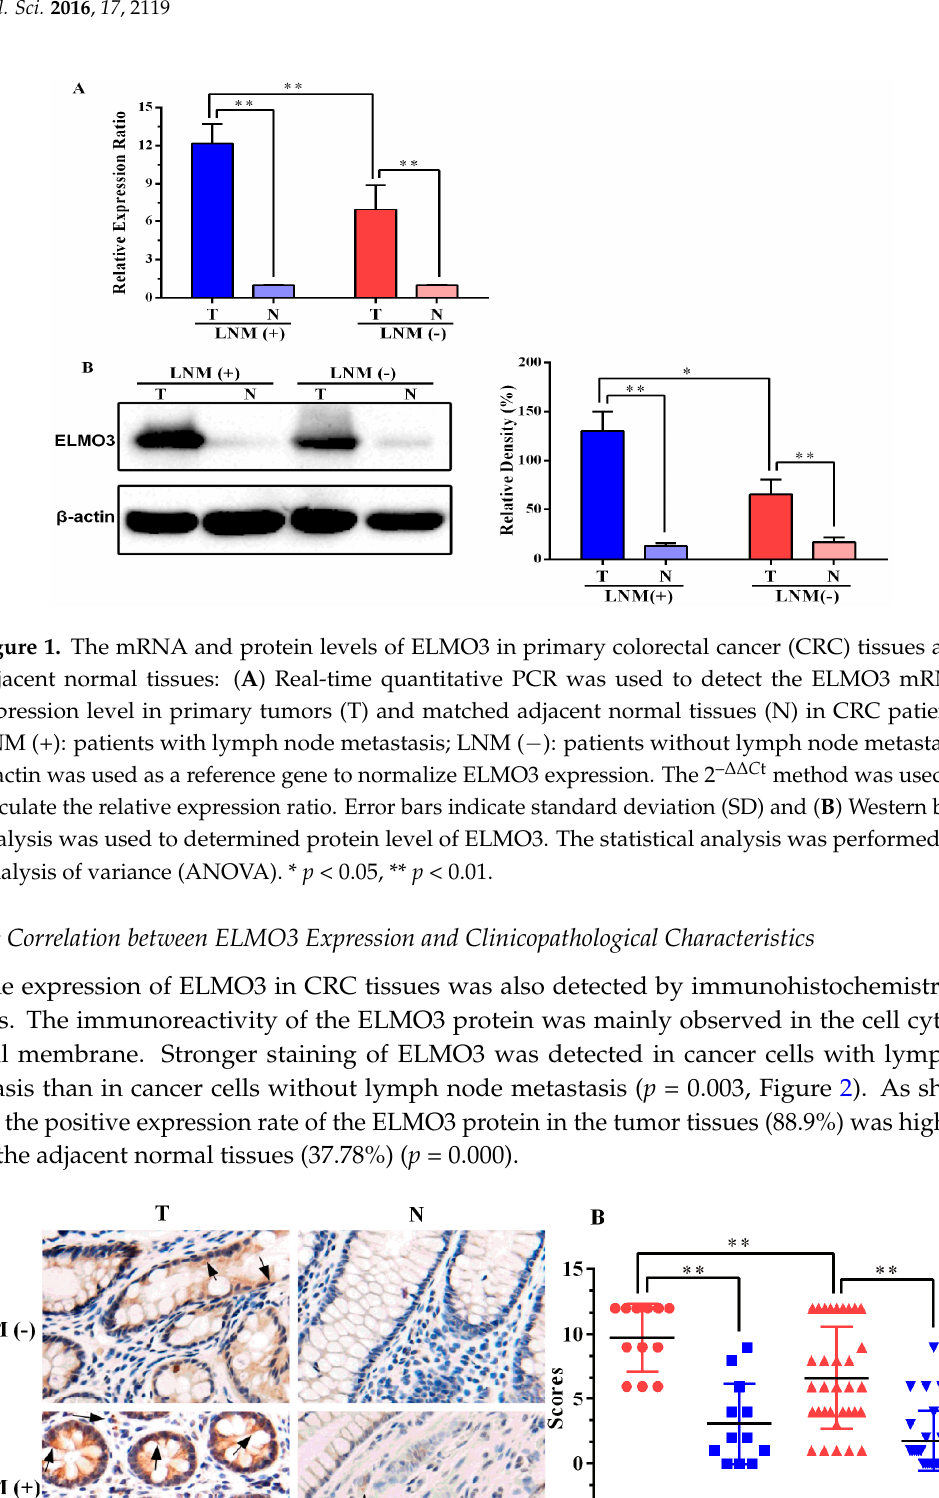
Figure 2. Immunolocalization of ELMO3 in primary CRC tumor tissues (T) and adjacent normal tissues (N): ( A ) The examination was carried out using immunohistochemical staining. LNM (+): patients with lymph node metastasis; LNM ( − ): patients without lymph node metastasis. Arrows